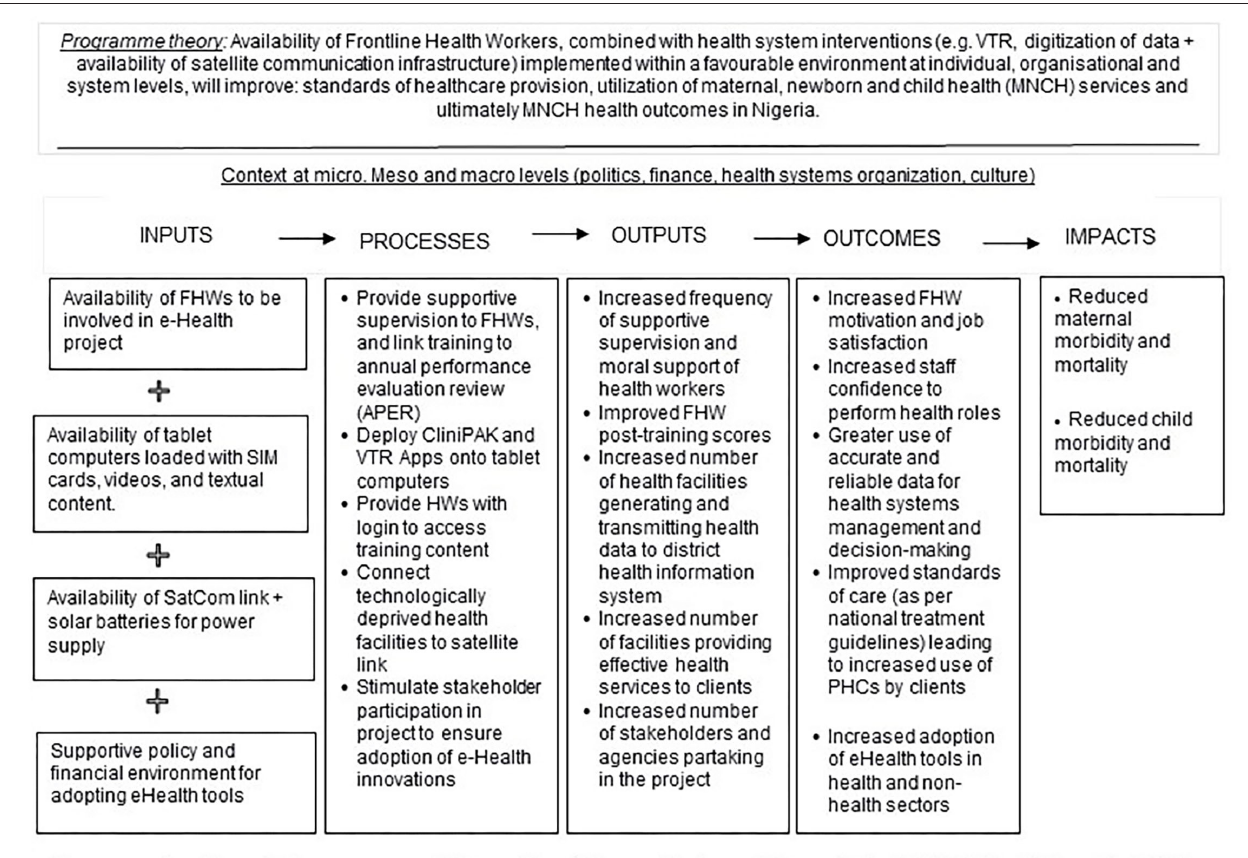
assessing the extent to which the outcomes achieved during end- line evaluation in Ondo State were sustained 12 months after the project